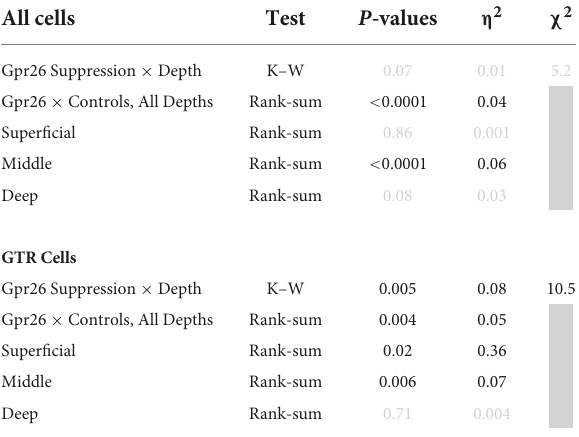
TABLE 1 Effects of illumination on cells in transgenic versus control